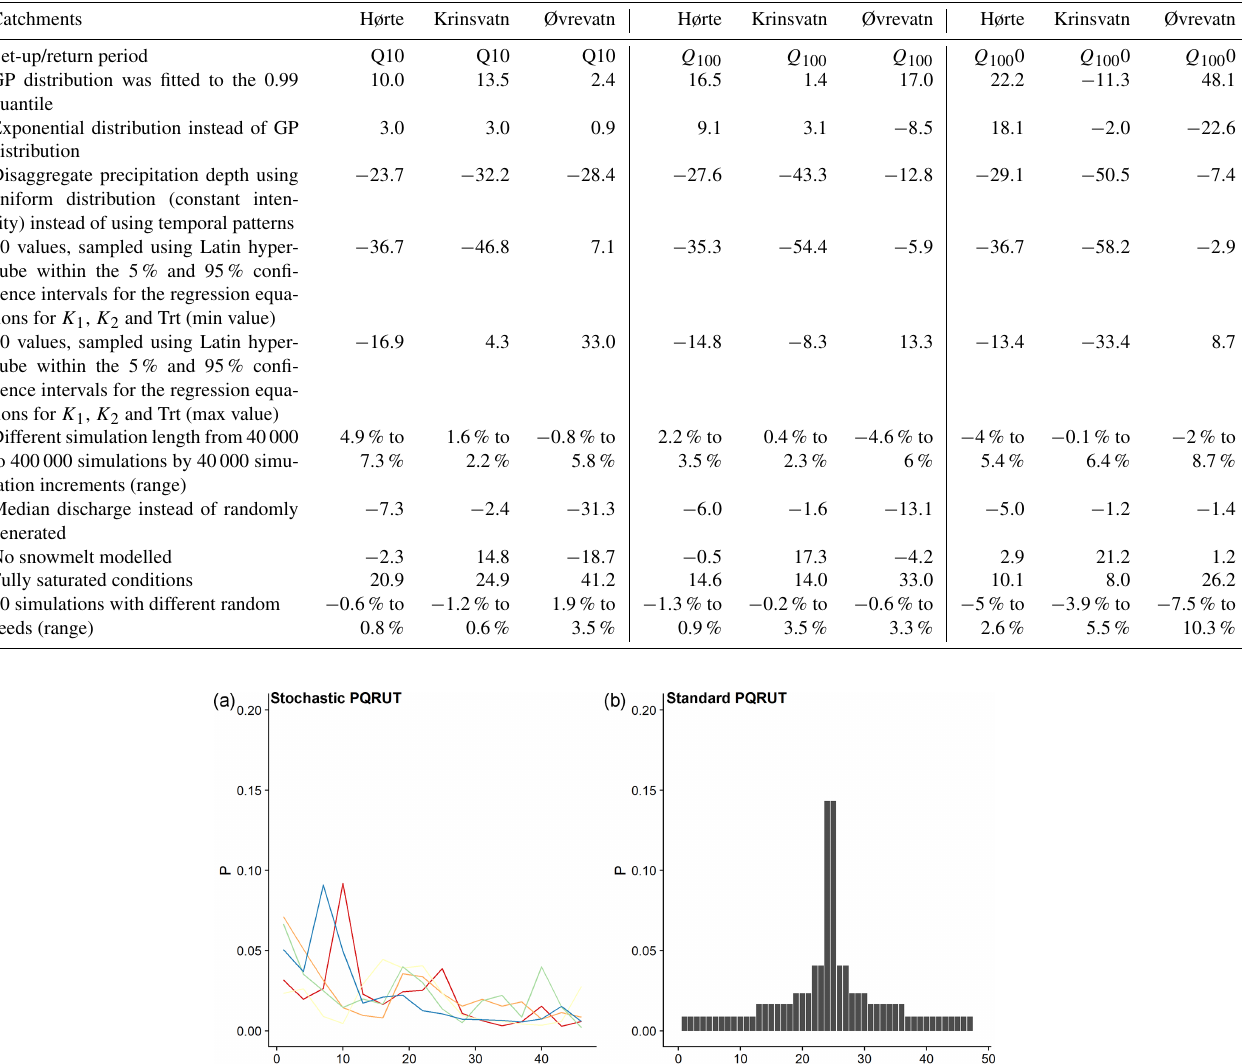
Table 4. Percent difference between the model runs of the sensitivity analysis to the calibrated model. Catchments